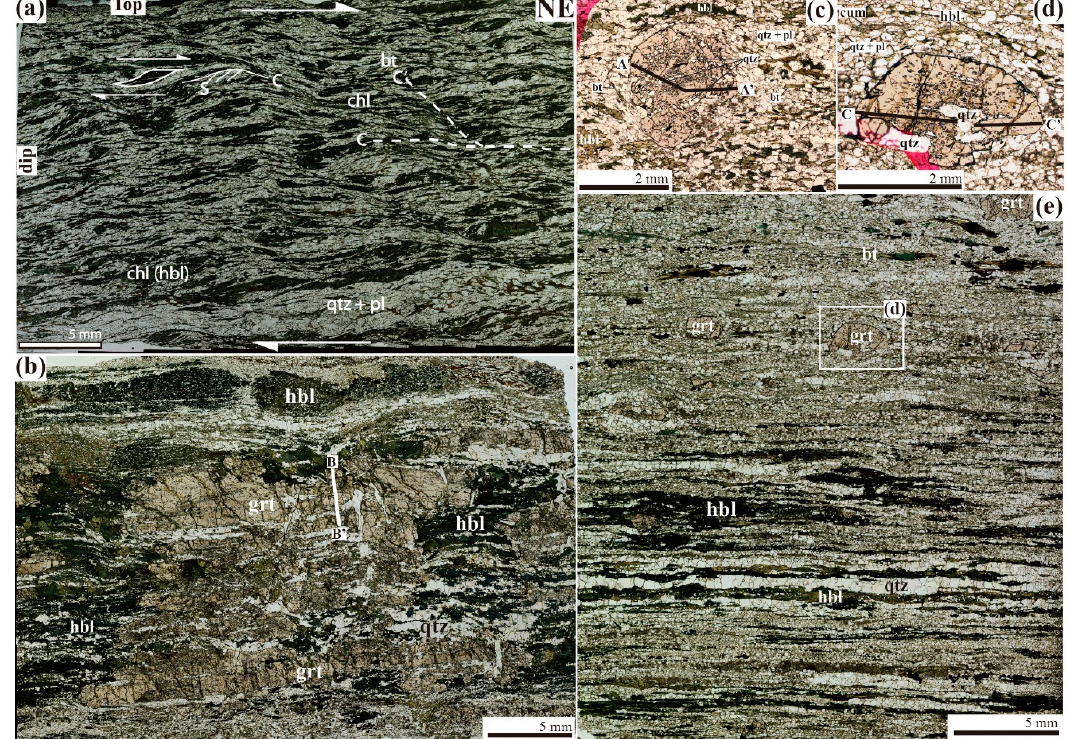
Figure 4. Microphotographs of mylonitic amphibolites from the Dessent Unit: ( a ) Retrogressed amphibolite (SB175A) with S–C–C’ fabric and chlorite (chl) fish: C’ denotes extensional crenulation cleavage (ECC). Chlorite pseudomorphs after hornblende (chl (hbl)) are common here. ( b ) Amphibolite (SB174B) showing an elongated garnet (grt) band and hornblende (hbl) stretching lineation: some parts (top layer) of hornblende form aggregates of fine-grains, possibly due to dissolution-precipitation. ( c , d ) Garnet porphyroblasts in amphibolites (( c ) SB173B and ( d ) SB176B) with associated minerals). ( e ) Amphibolite (SB176B) showing distinct dynamic recrystallization textures: recrystallized quartz (qtz) forms an elongated band or a polygonal granoblastic fabric, and hornblende exhibits strong stretching lineation. Garnet profiles (A–A’, B–B’ and C–C’) shown in Figure 8 are presented in ( c ), ( b ) and ( d ), respectively. Photos were taken under a plane-polarized light. Abbreviations: bt, biotite; cum, cummingtonite; pl, plagioclase.